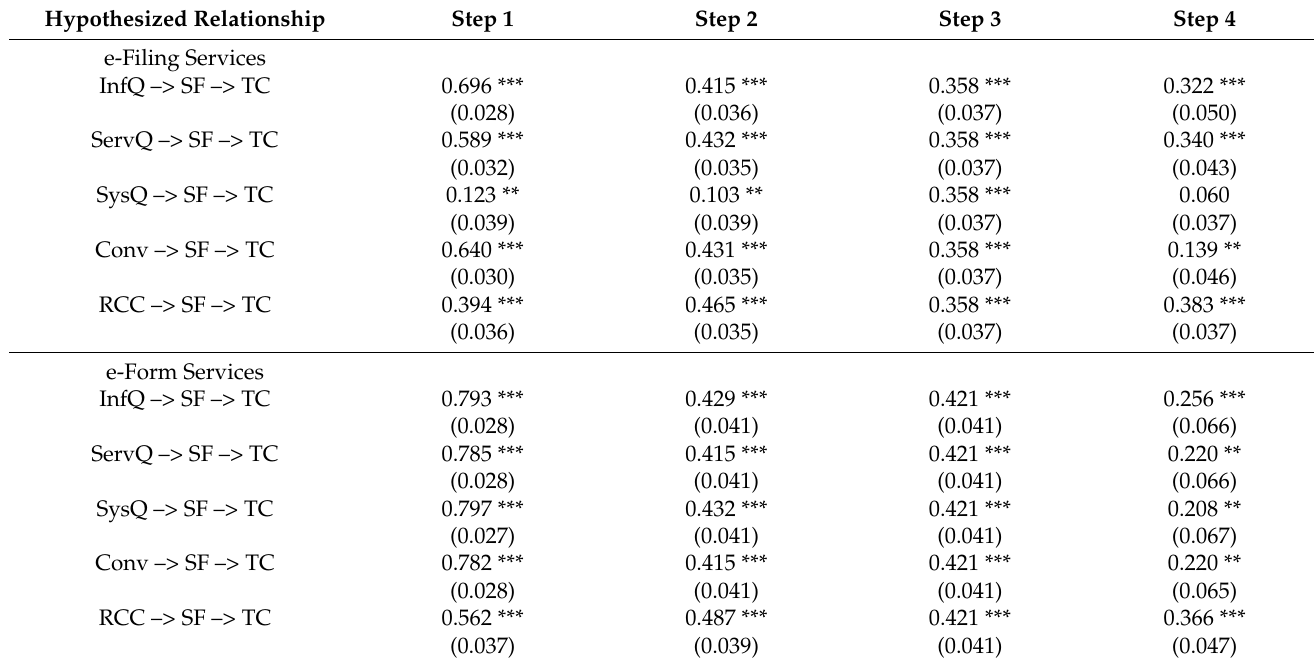
Table 8. Mediation analysis (results of hierarchical